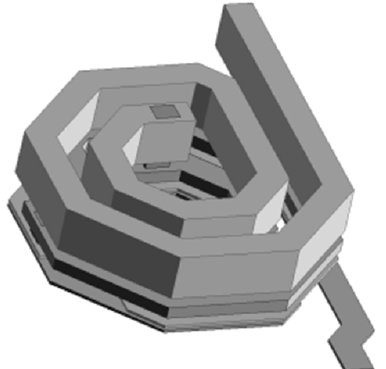
Figure 10. Implementation of the stack inductor.